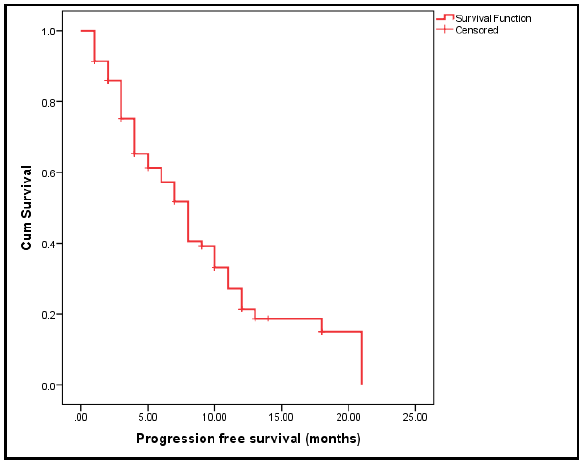
Figure 1: Kaplan-Meier progression-free survival curve for all